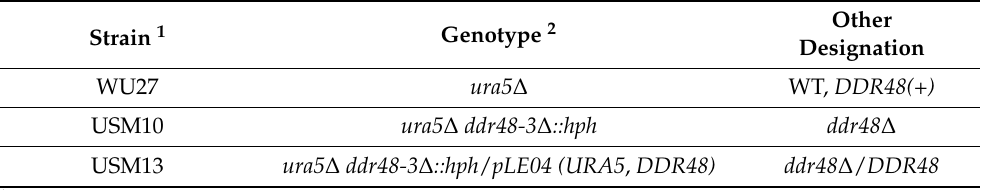
Table 1. Histoplasma strains used in this study. Strain 1 Genotype